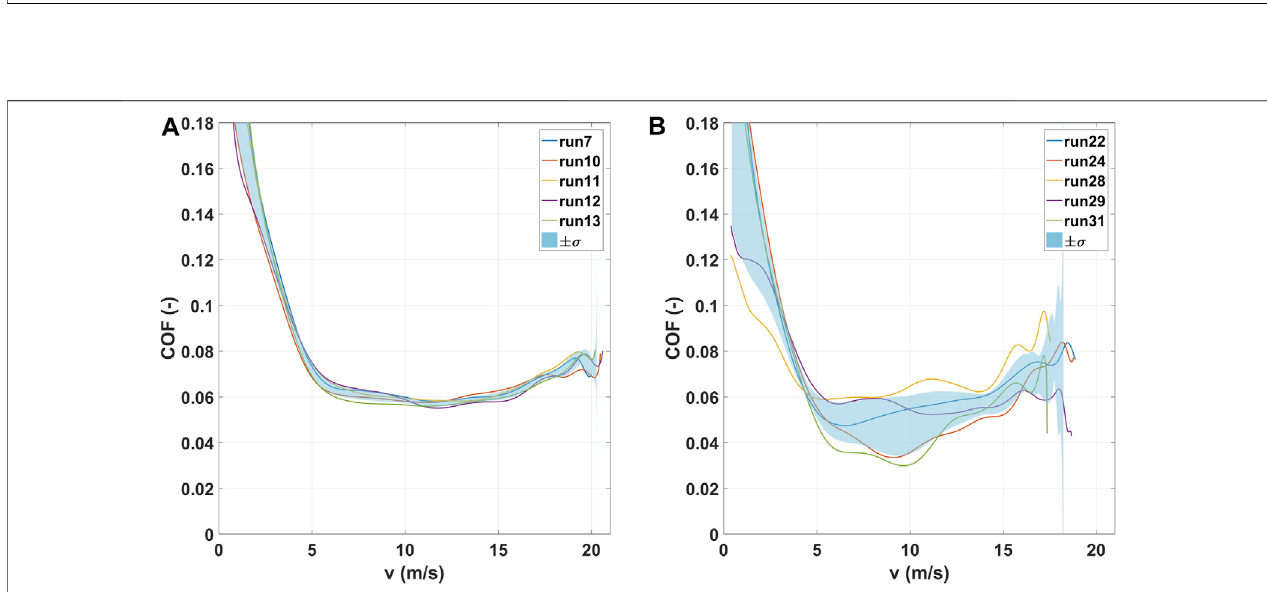
Frontiers in Mechanical Engineering |